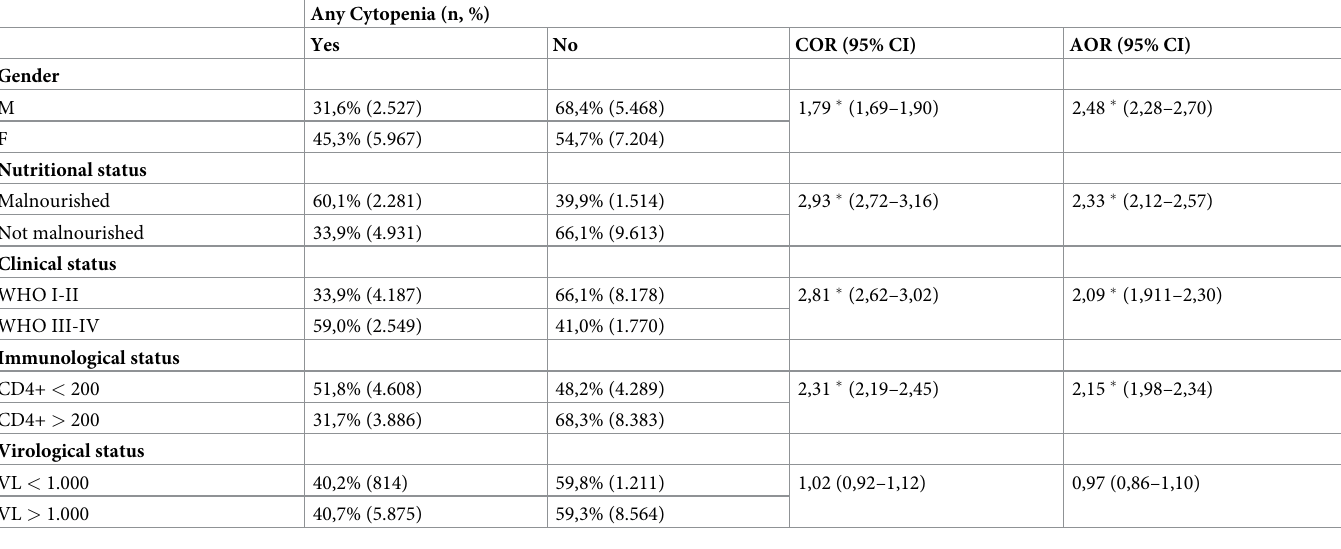
Table 5. Factors associated with any cytopenia (univariate and multivariate analyses).